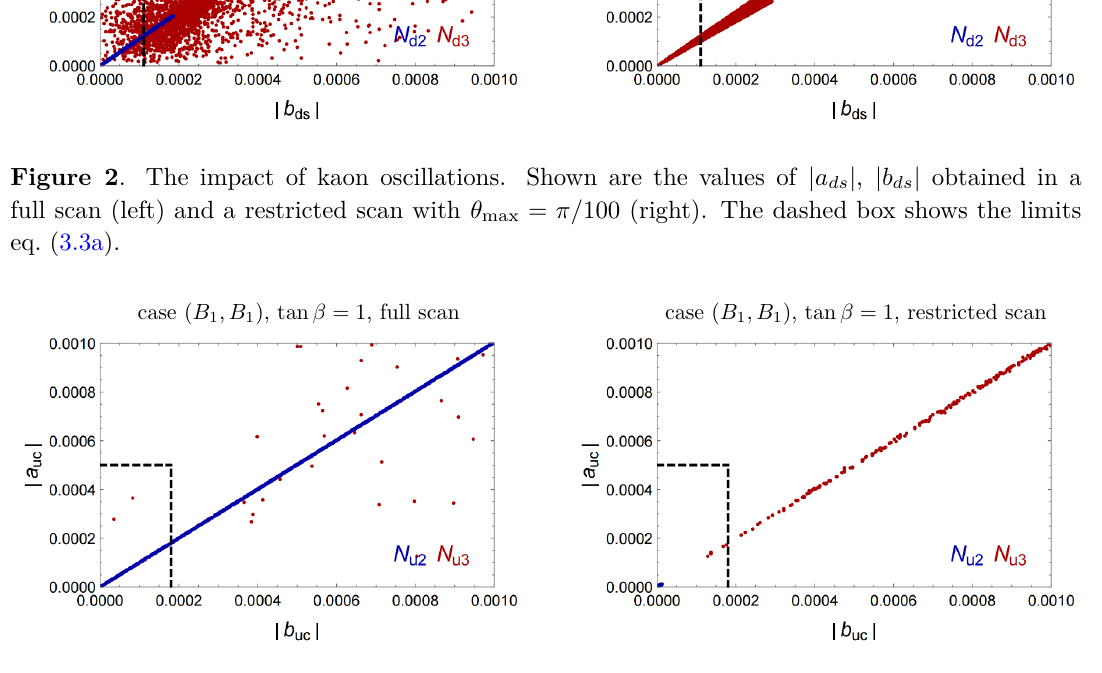
model expectations, where N the block-diagonal form (5.4). Due to ( N